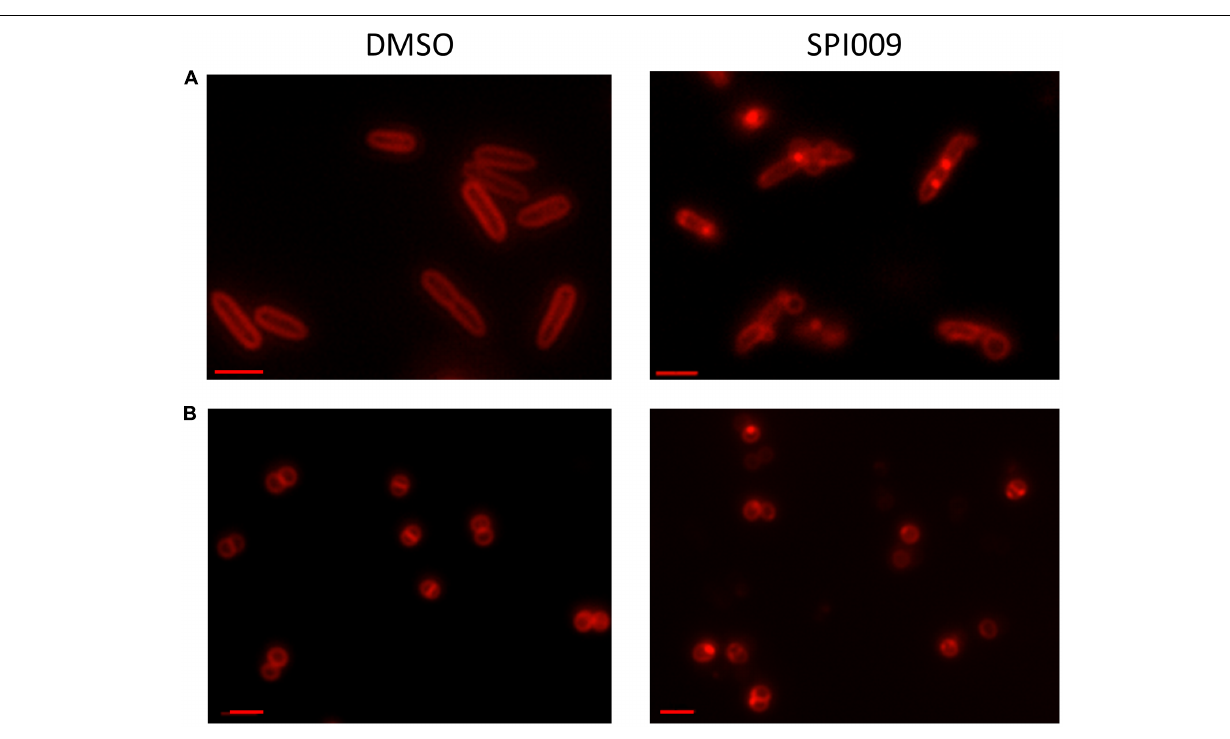
FIGURE 6 | Microscopic confirmation of SPI009 induced membrane damage. Overnight cultures of (A) P. aeruginosa and (B) S. aureus cultures were treated for 20 min with 1% DMSO (carrier control) or 34 µ g/mL of SPI009. Treated cells were stained with 10 µ g/mL of FM R (cid:13) 4-64 and visualized using a Zeiss Axio imager Z1 fluorescence microscope equipped with an EC Plan-NEOFLUAR 100 × objective ( λ ex = 540–580 nm; λ em = 593–668 nm). Scale bars correspond to 2 µ M. Pictures are representatives of repeated